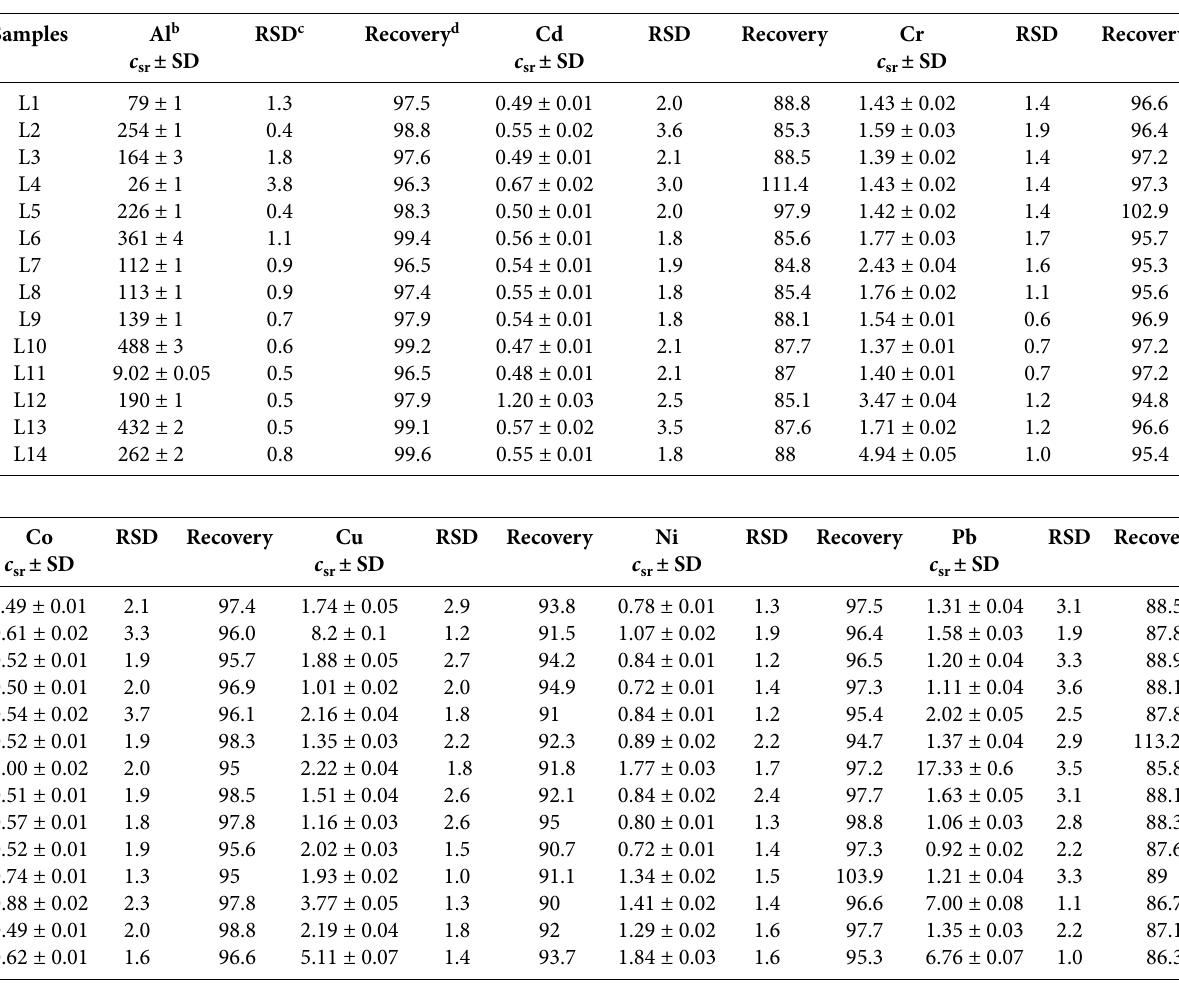
Table 3. Spiked concentration a (mg kg –1 ) of elements in lipstick samples and recovery test ( n = 3)